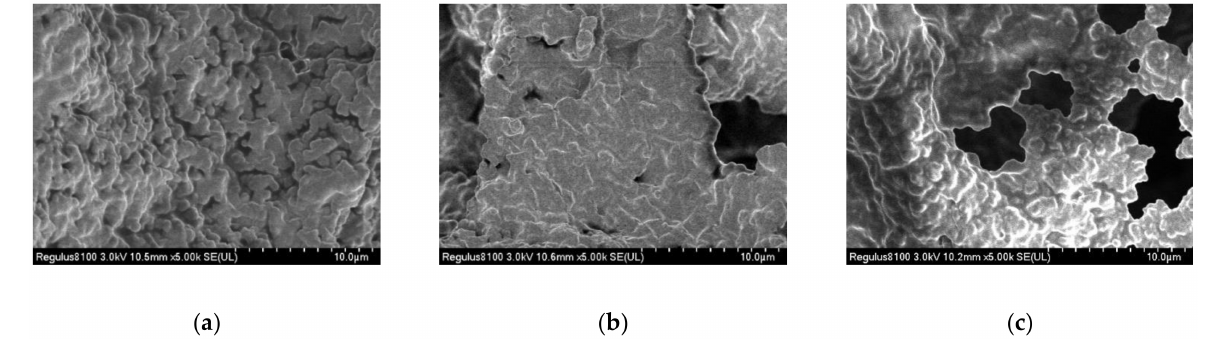
Figure 7. Scanning electron micrographs of set yogurt containing different concentrations of M-EPS with magnification of 5000 × . ( a ) +0% M-EPS; ( b ) +0.1% M-EPS; ( c ) +0.5% M-EPS.